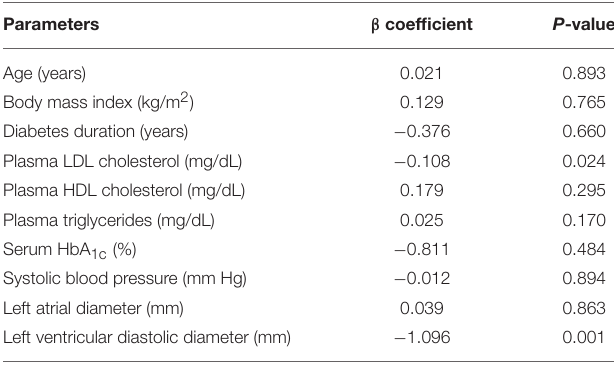
TABLE 3 | Multivariate regression analysis of parameters associated with left ventricular ejection fraction.